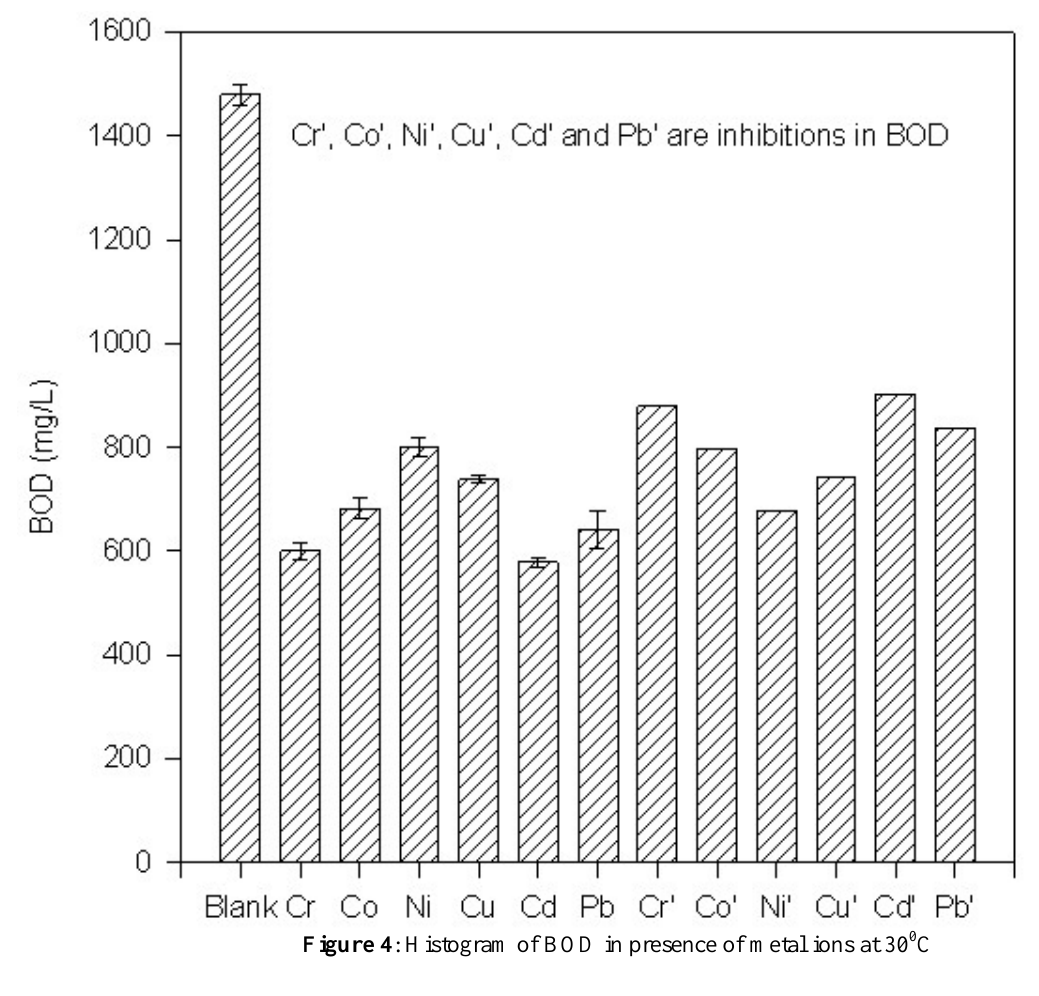
Figure 4 : Histogram of BOD in presence of metal ions at 30 0